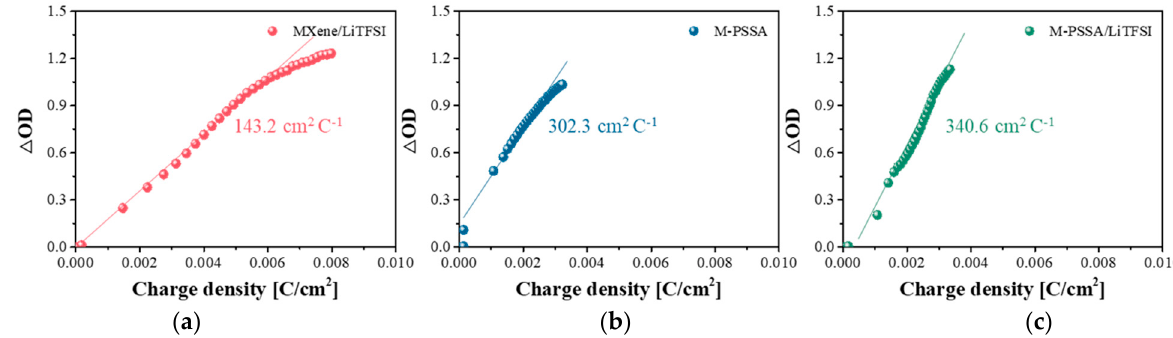
Figure 6. Coloration efficiency at the wavelengths of 600 nm of ( a ) MXene/Bis(trifluoromethylsulfonyl)amine lithium salt (MXene/LiTFSI), ( b ) poly(4-styrenesulfonic acid) crosslinked with MXene (M-PSSA) and ( c ) 1:20 LiTFSI in MXene-PSSA(M-PSSA/LiTFSI).